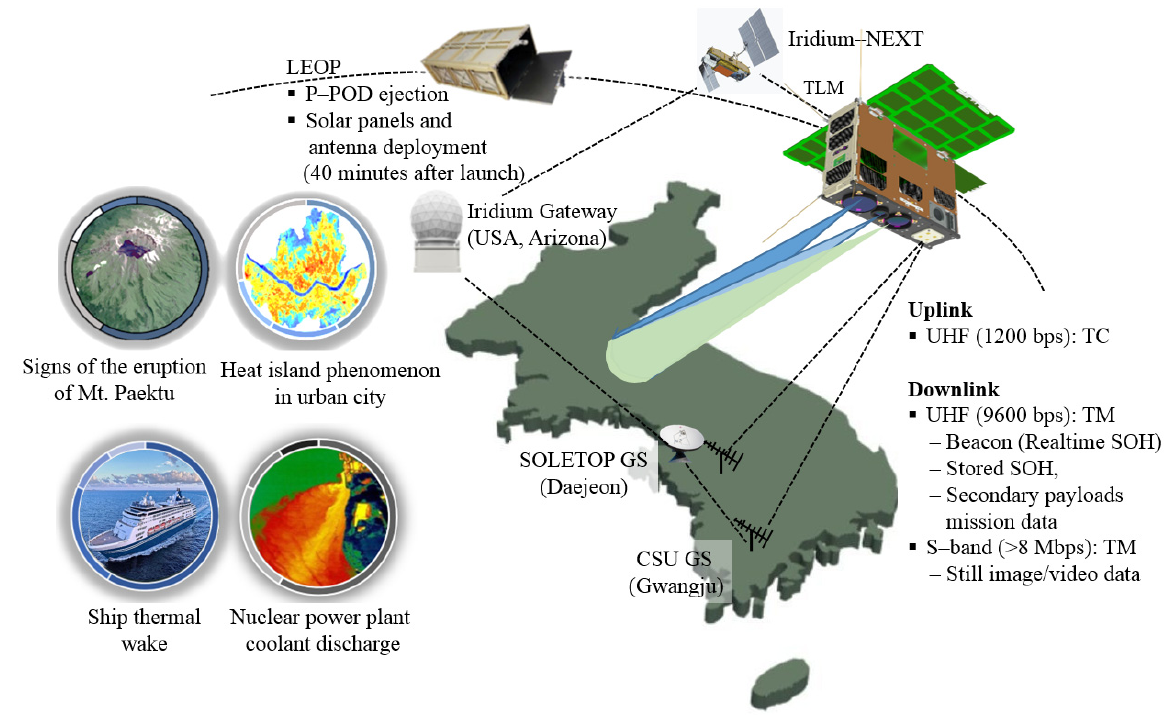
Figure 1. The system architecture of the Space Technology Experimental Project CubeSat Laboratory (STEP Cube Lab)-II CubeSat’s mission.